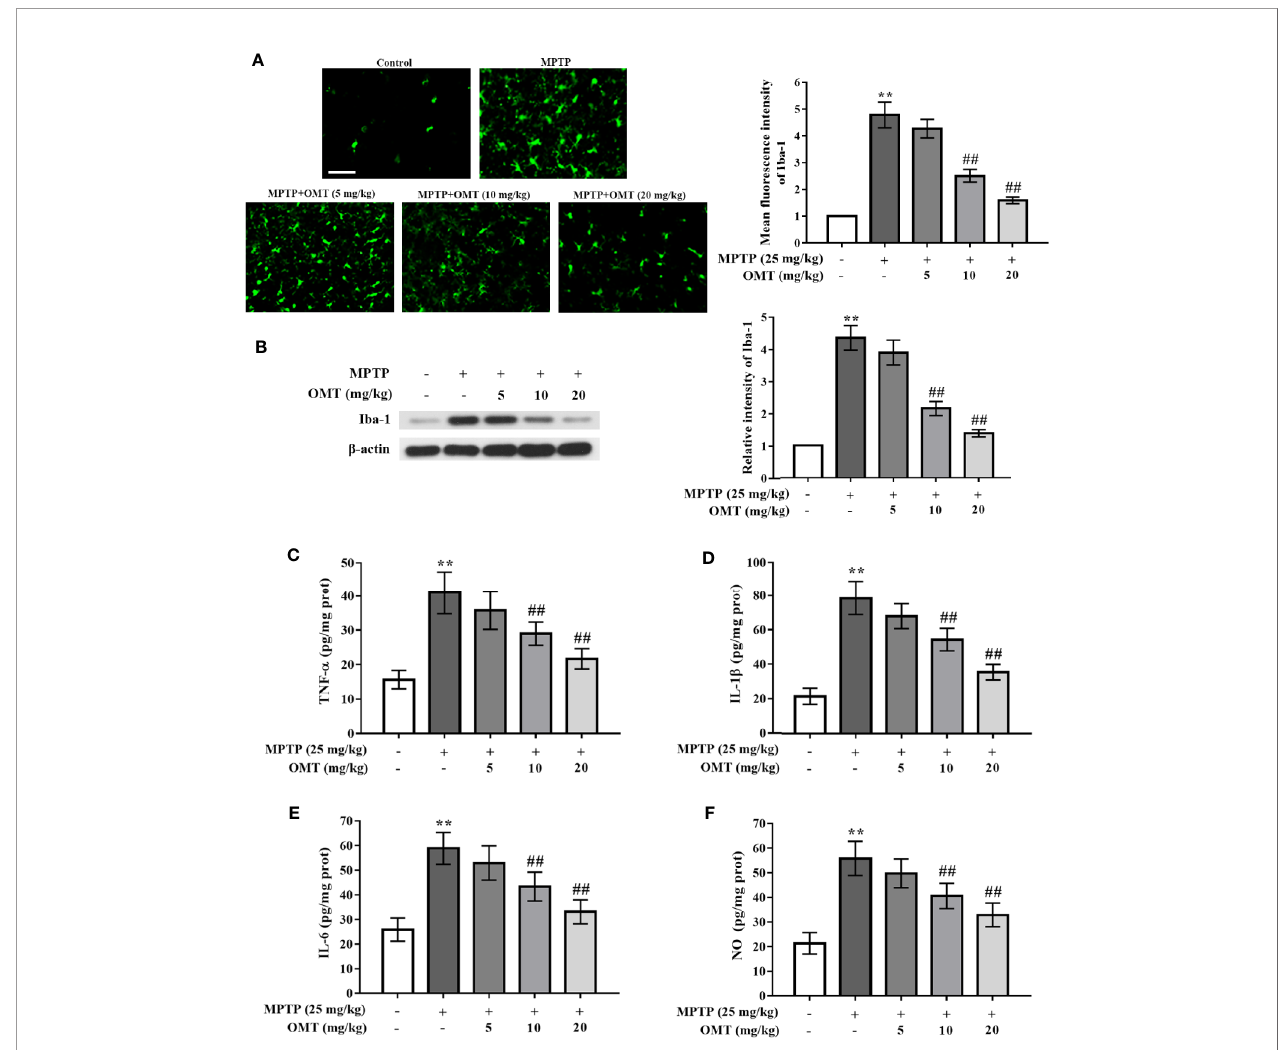
FIGURE 2 | OMT attenuated microglia activation and suppressed pro-in fl ammatory cytokines production in MPTP-induced PD mice model. (A) Immuno fl uorescence staining for Iba-1 positive microglia in SNpc area after administration with OMT in MPTP-induced PD mice. Scale bar: 100 m m. (B) The expression of Iba-1 in midbrain was determined by Western blot analysis. (C – F) Levels of pro-in fl ammatory cytokines, such as TNF- a (C) , IL-1 b (D) , IL-6 (E) , and NO (F) in midbrain were tested by ELISA (C – E) and Griess (F) regent, respectively. The data are presented as mean ± SEM. **p < 0.01 vs. Control group; ## p < 0.01 vs. MPTP group. ANOVA with Bonferroni ’ s post-hoc